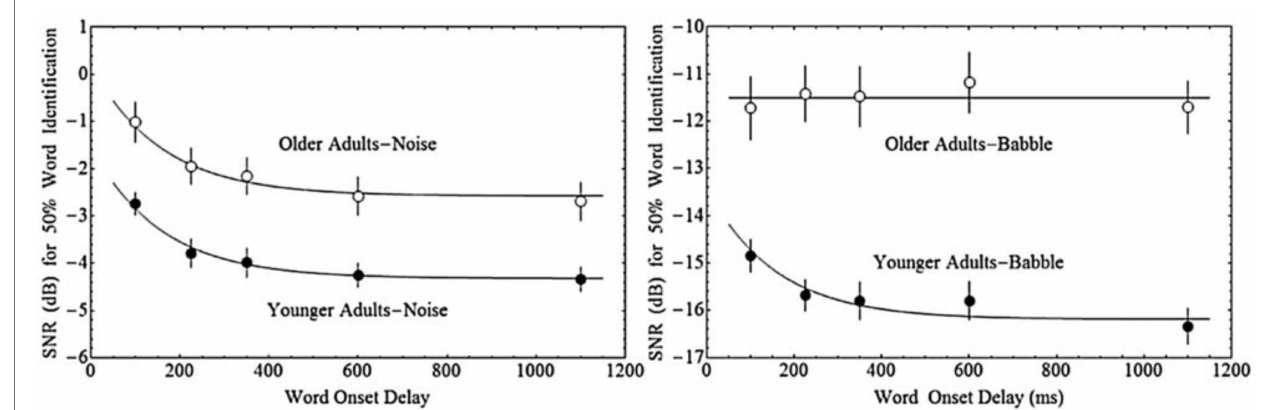
FIGURE 1 | Fifty percent word identification thresholds as a function of the onset delay between the masker and the target word for younger and older adults in either Steady-State Noise, or multi-talker Babble. Adapted with permission from Ben-David et al.